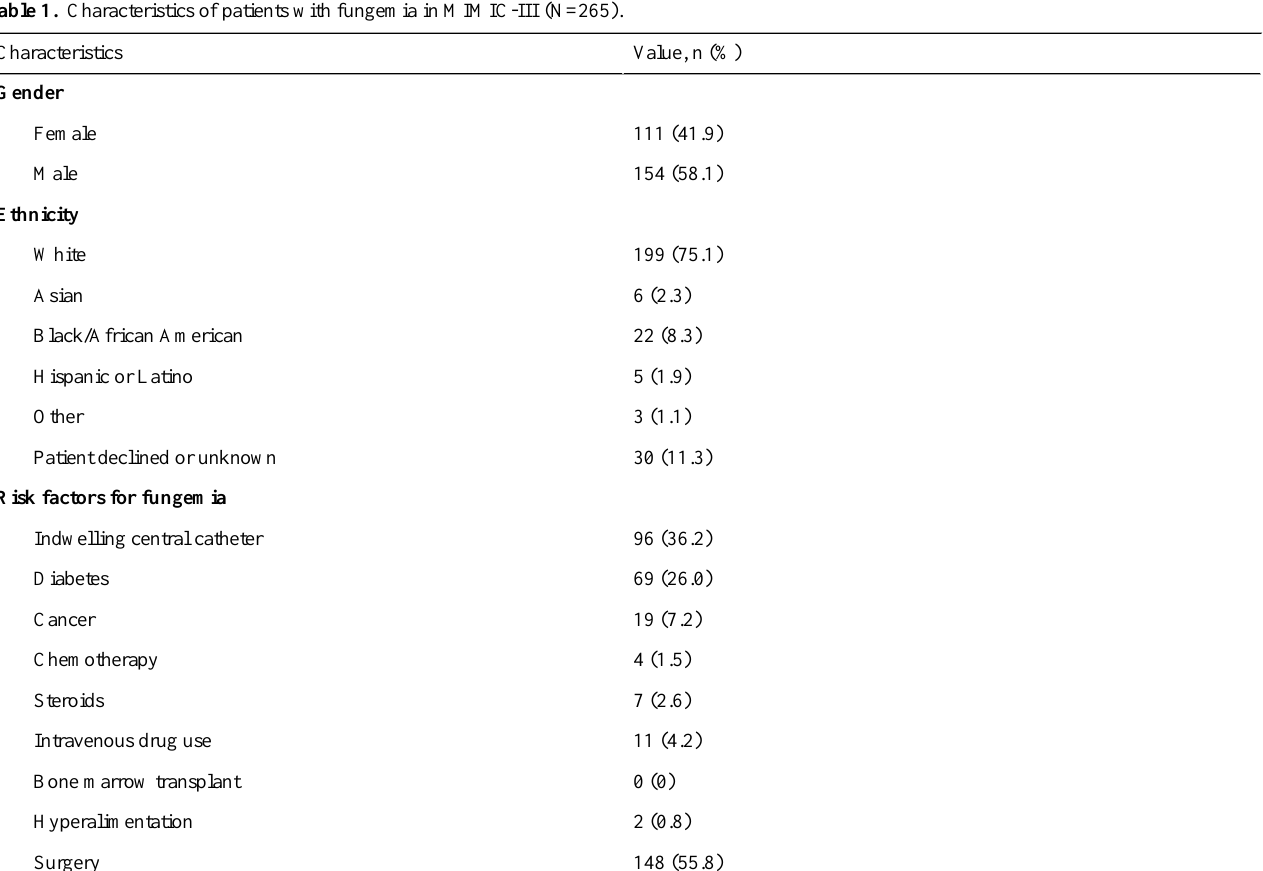
Table 1. Characteristics of patients with fungemia in MIMIC-III